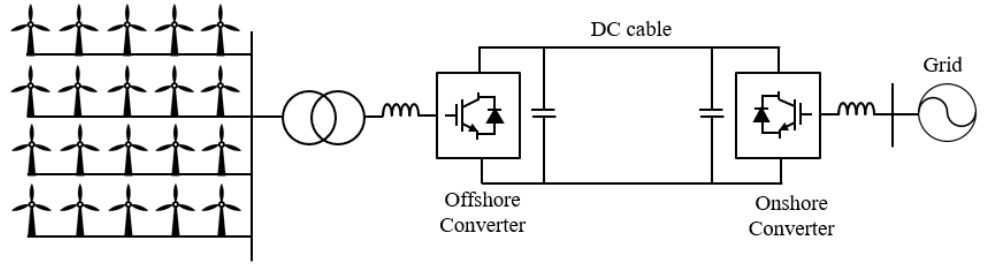
Figure 5. Configuration of the 200 MW monopolar HVDC system for the FOWF.